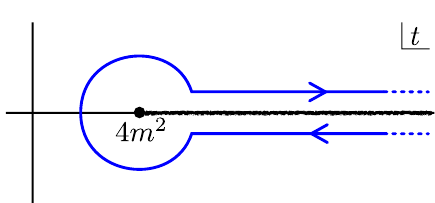
Figure 10 . The discontinuity of the Mandelstam equation (3.9) has been obtained by deforming the contour of integration in the finite integral (3.8). Hence, the result cannot diverge. This means that an apparent divergence in (5.13) that comes from the region of integration close to the threshold should be understood as a finite keyhole contour integral plotted